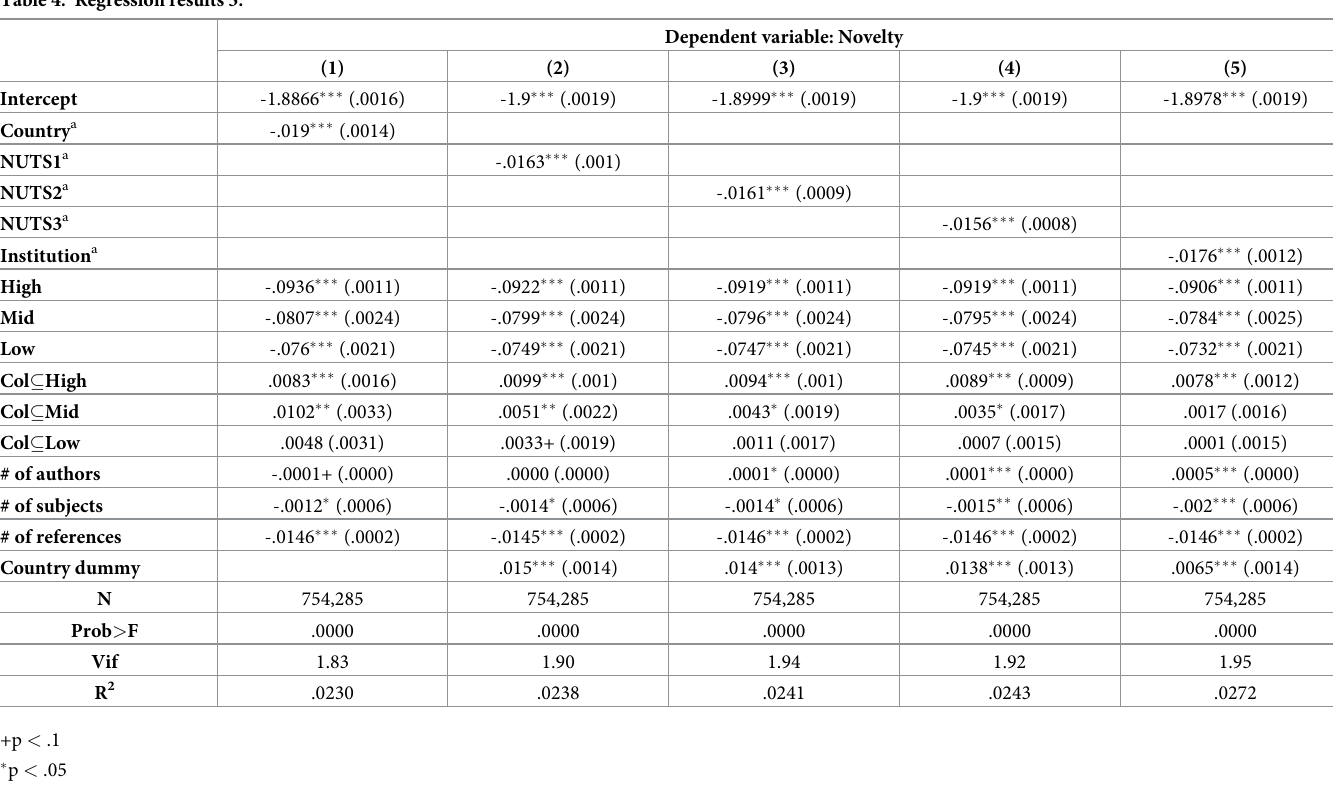
Table 4. Regression results 3.